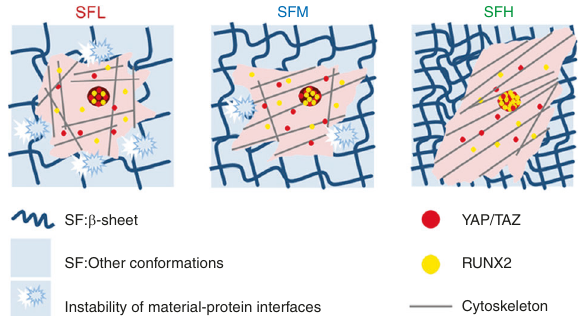
Fig. 7 The molecular conformation of SF regulates osteogenic cell behavior by modulating the stability of the adsorbed protein- material interface. Applying FN as a model cellular adhesive protein, the surface stability of the SF substrates and the accompanying detachment resistance of adsorbed protein on these SF substrates increased with increasing β -sheet content. Furthermore, more cytoskeleton-associated FAs, higher orders of cytoskeletal organization, and more elongated spreading shapes were observed in the BMSCs cultured on the SFH surface than in those cultured on the SFL surface, along with the enhancement of nuclear translocation and activation